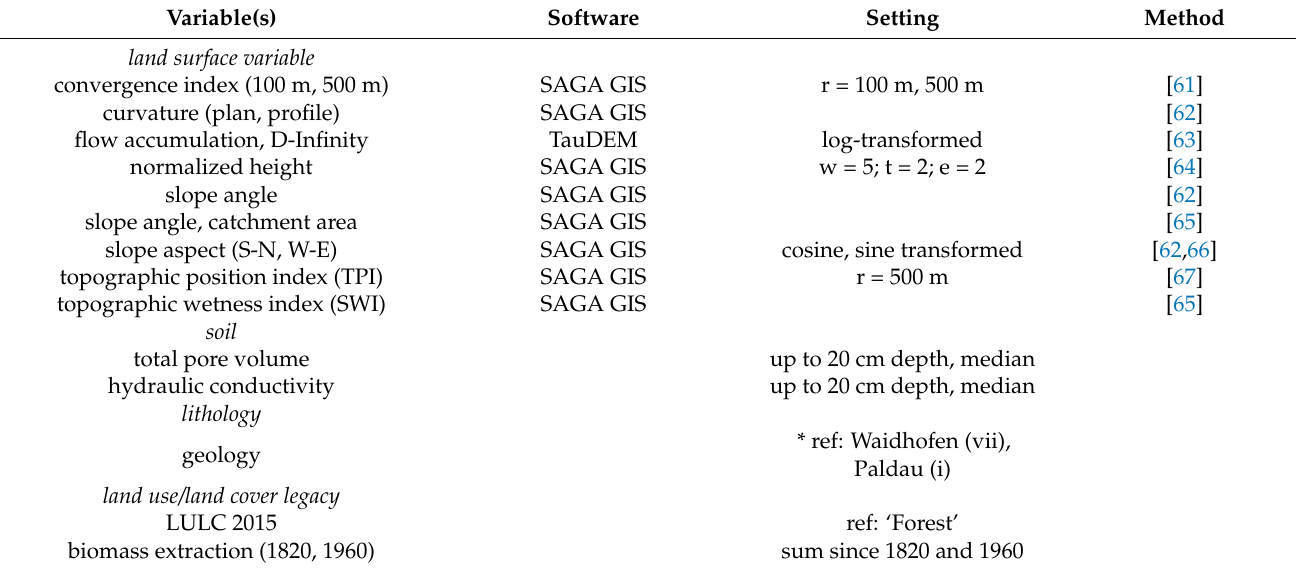
Table 2. Predictor variables for landslide susceptibility